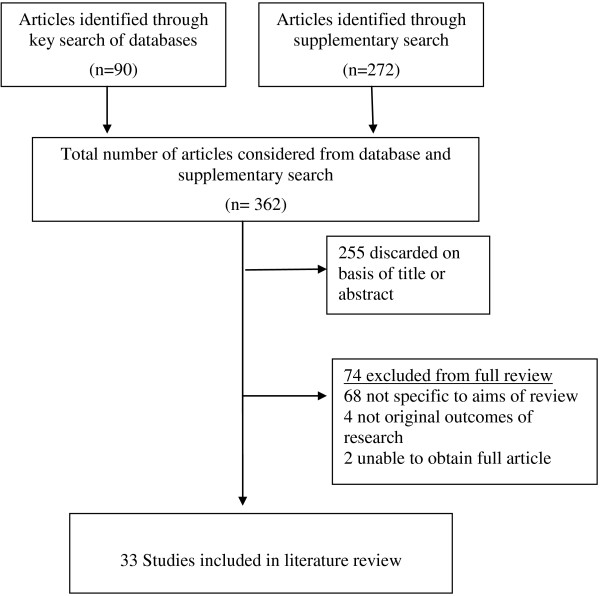
Search flow diagram.